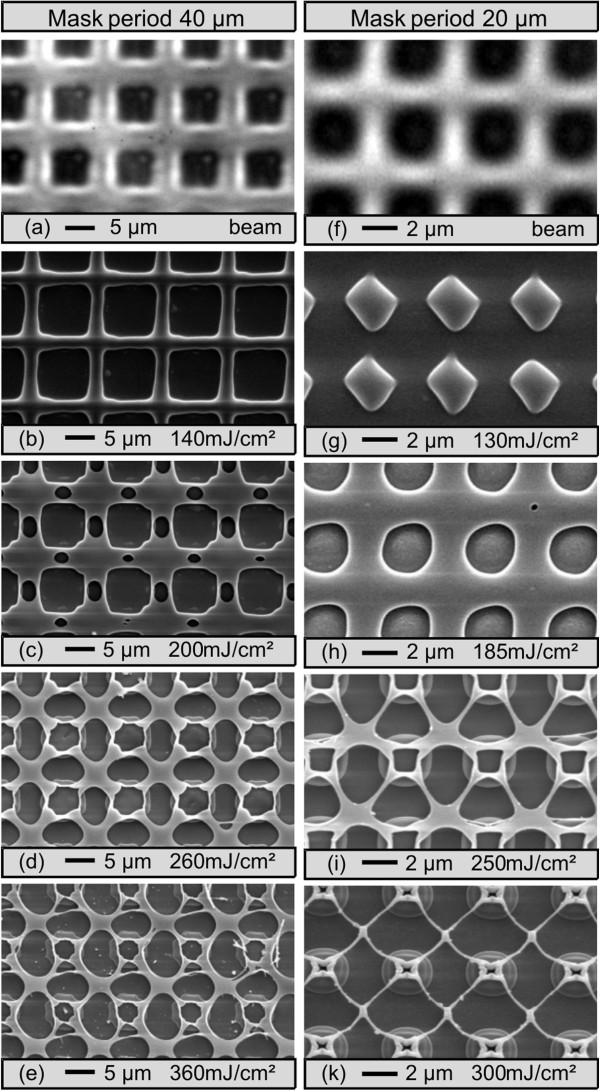
Fluence dependence of the structure formation. Intensity distribution in the sample plane (a, f) (contrast enhanced for clarity) and corresponding patterns in 150-nm-thick SiOx films obtained with single pulses of varying fluences at 248 nm, mask period 40 μm (b to e), and mask period 20 μm (g to k).